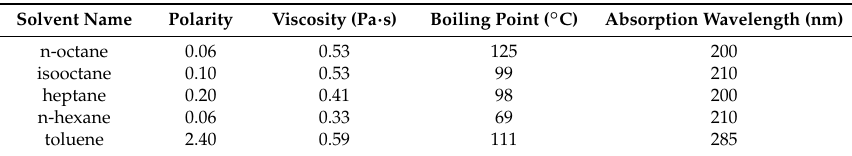
Table 1. Summarized properties of different